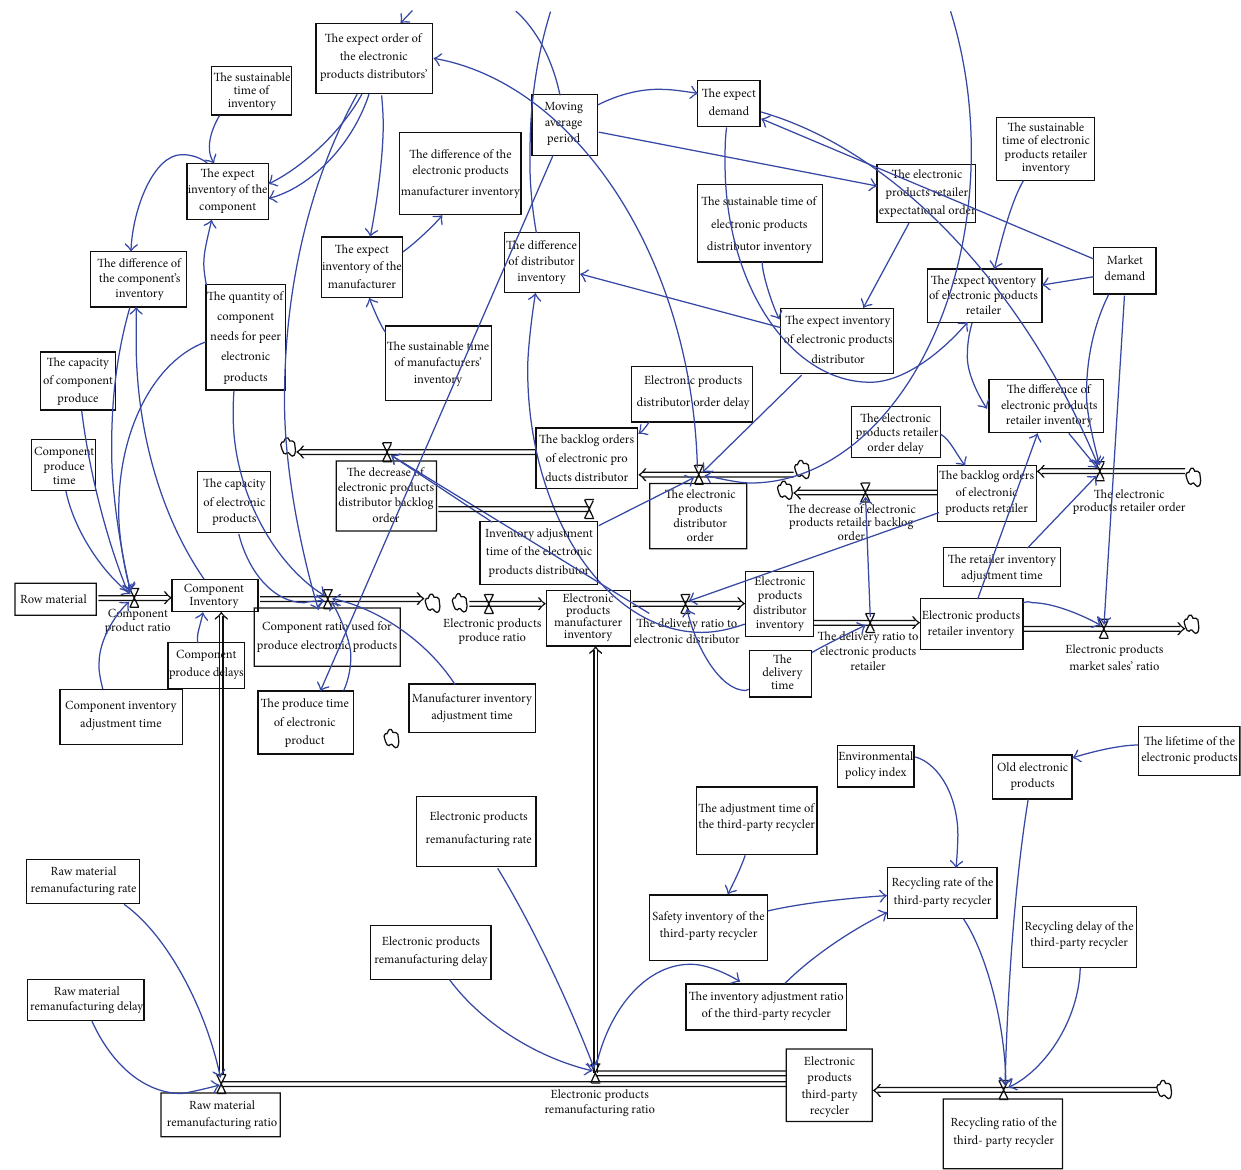
Figure 2: The electronic products closed-loop supply chain dynamic flow